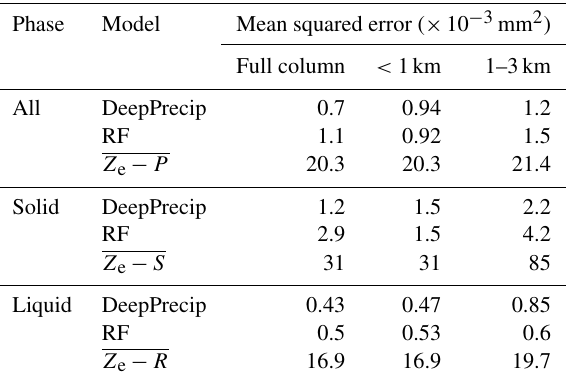
Table 6. MSE values (in × 10 − 3 mm 2 ) for all vertical extent exper- iments across all models for both solid and liquid